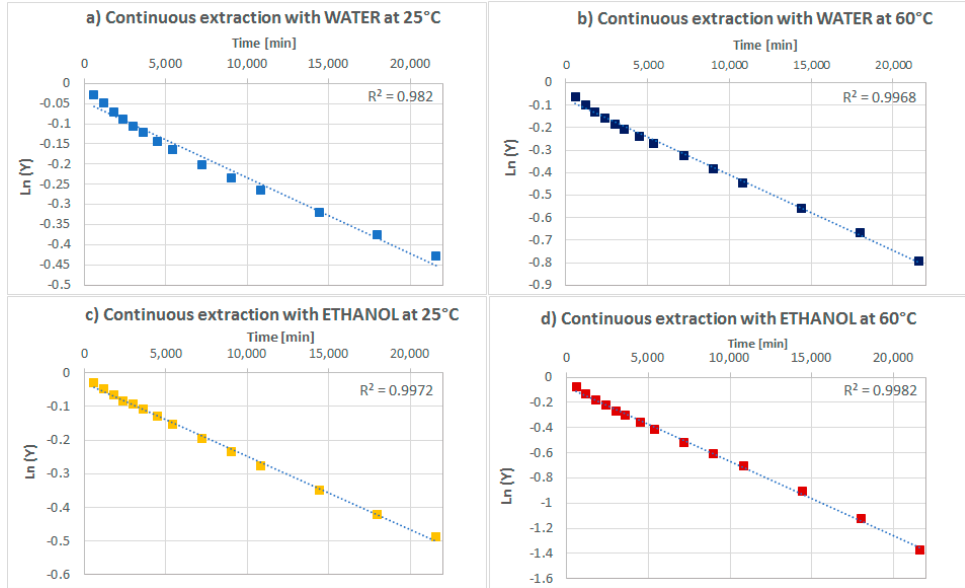
Figure 3. Unextracted fraction of polyphenols against time in a solid-liquid continuous extraction in ( a ) water at 25 °C; ( b ) water at 60 °C; ( c ) ethanol 50% at 25 °C and ( d ) ethanol 50% at 60 °C. The values of the effective diffusion coefficients are presented in Table 2. Table 2. Obtained values of the effective diffusion coefficient of polyphenols extracted by Sterculia apetala seeds in a continuous extraction with water and ethanol 50% at 25 °C and 60 °C. Solvent